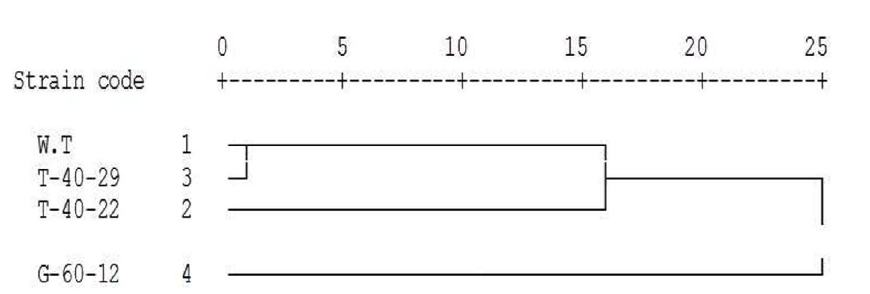
Fig. 5. Dendrogram using Average Linkage of the three mutant strains in comparison with W.T based on PCR-RAPD assay. Table 6. Types and number of the amplified DNA bands as well as the total polymorphism percentage generated by three RAPD primers Primer Total Monomorphic Unique Polymorphic Polymorphic